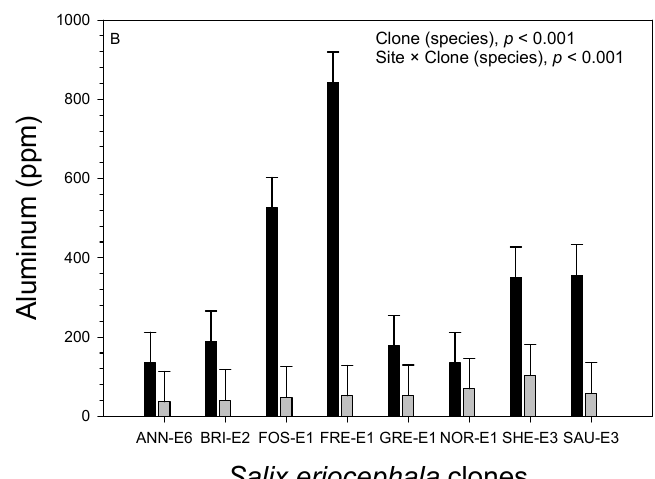
Figure 7. Foliar aluminum concentrations (mean ± SE) from 15 genotypes of ( a ) Salix discolor (seven) and ( b ) S. eriocephala (eight) on acidic clay and shale overburden sites. Covariate analysis of total aboveground green mass, using macronutrients or metals as the covariate and testing species effect, showed no significant nutrient/metal effects, species effects, or species × nutrient/metal interaction for any of the 12 foliar nutrients, metals or C:N ratio (Table 3), except for Ca. Green mass showed a significant Ca × species interaction ( p = 0.019), species ( p = 0.027), and Ca ( p = 0.008) effects. Green mass had a different positive slope in relation to increasing Ca concentration, with a steeper slope for DIS than ERI (Figure 8).